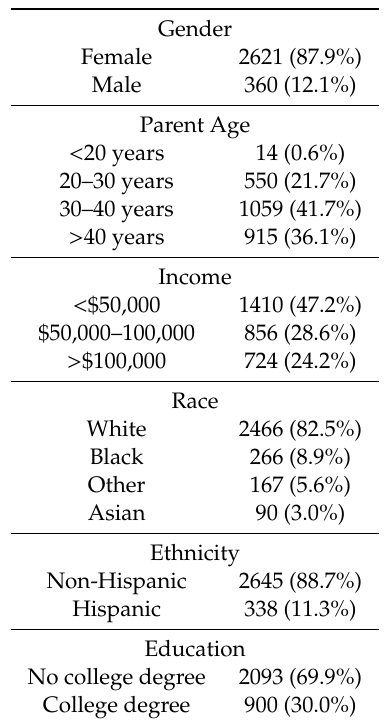
Table 1. Demographic Characteristics of Parent Participants ( n =